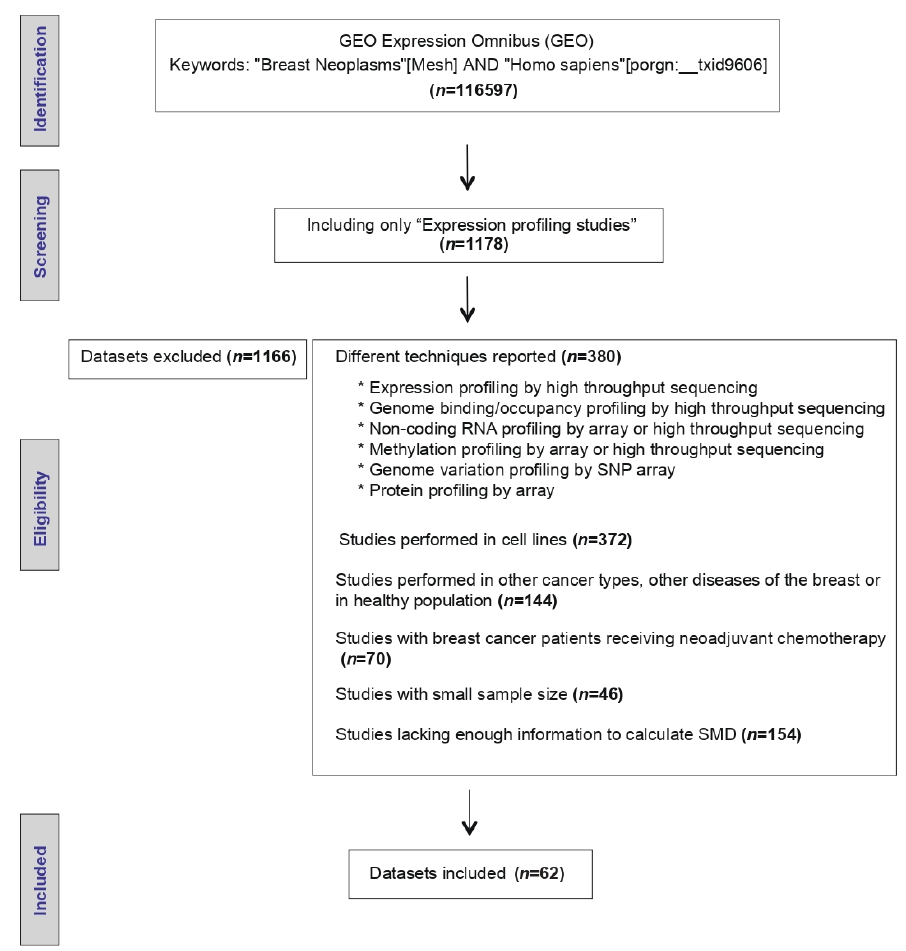
Figure 1. Workflow of the included Gene Expression Omnibus (GEO) datasets. Table 1. Clinical characteristics of BC patients.